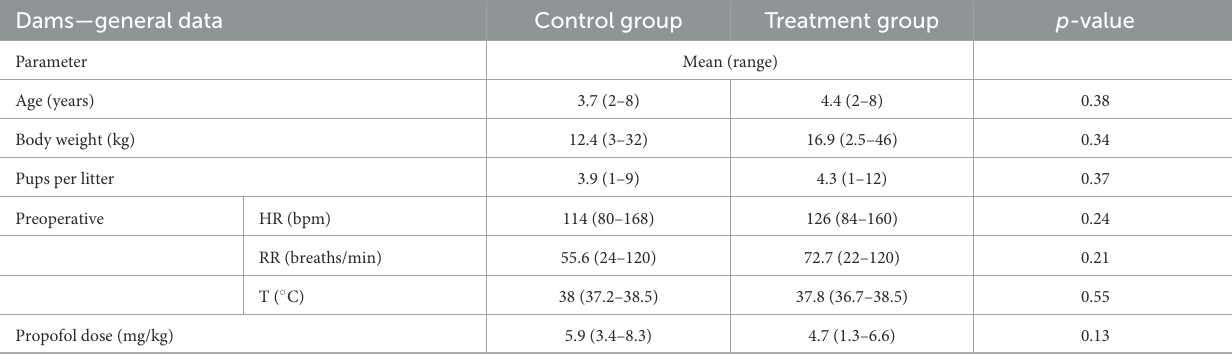
TABLE 1 General clinical data and preoperative parameters in bitches without (control group) or with (treatment group) fluid coload. Dams—general